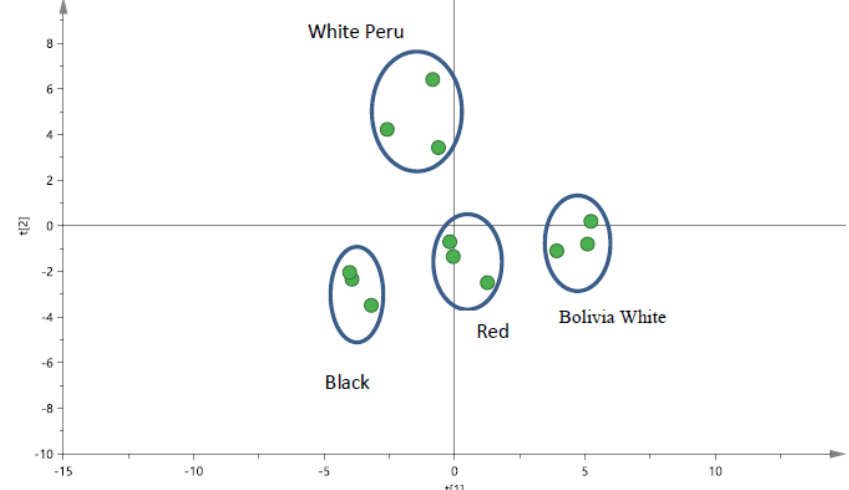
Figure 1. PCA score plot for quinoa seeds samples (pulverised) by pXRF for black quinoa seeds, red quinoa seeds and two different types of white quinoa seeds (Bolivia and Peru).